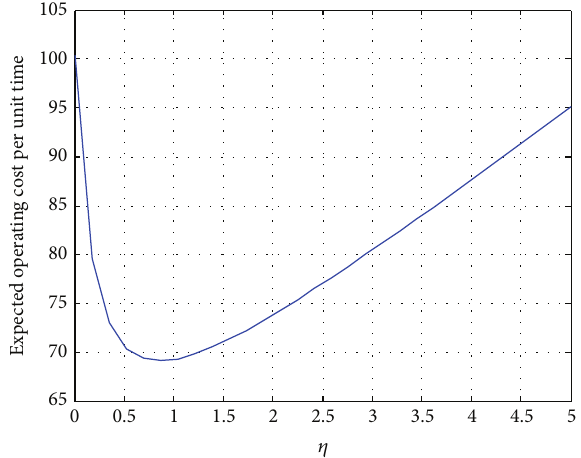
Figure 8: Effect of 𝜂 on the expected operating cost per unit